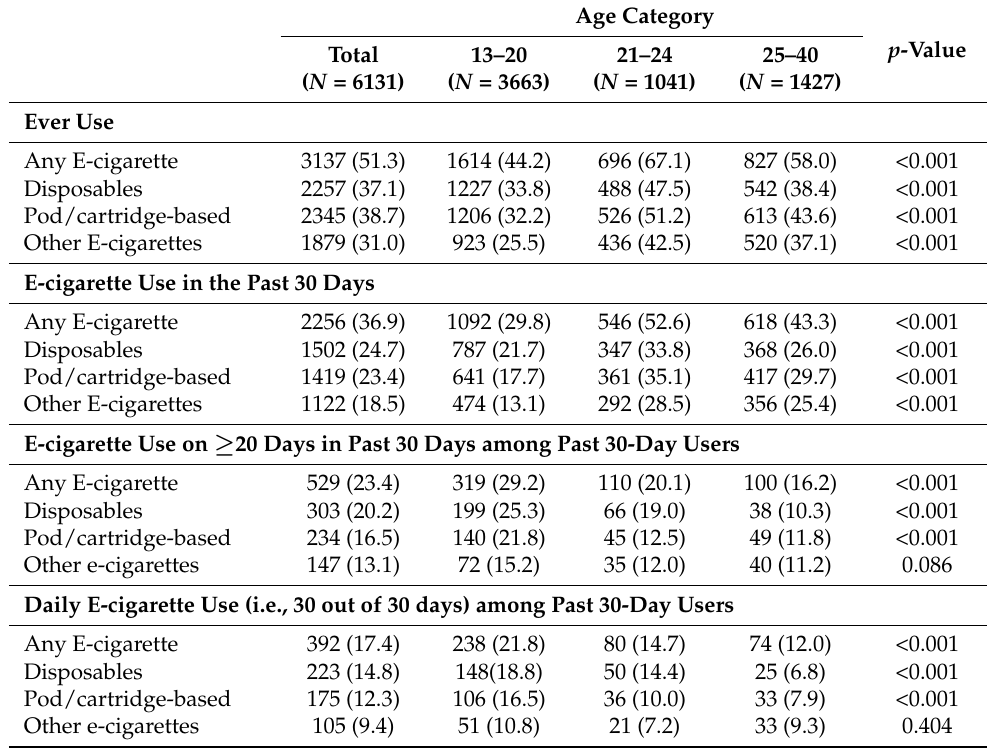
Table 1. Ever, past 30-, and past 7-day e-cigarette use by age category and device type, no.